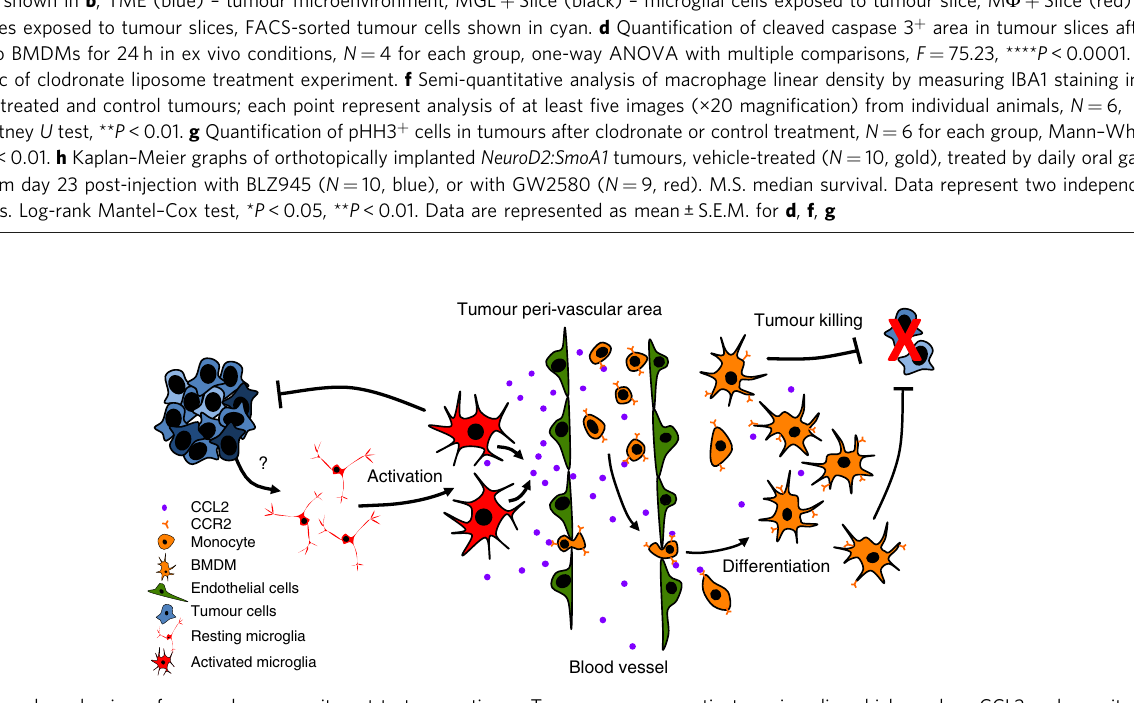
Fig. 5 Cultured macrophages and microglial cells lead to tumour cell death ex vivo. a Schematic of experiment: bone marrow cells were extracted from control B6 mice and allowed to differentiate in culture for 6 days prior to exposure to organotypic medulloblastoma tumour slices. Loosely adherent microglial cells were isolated from brain cell culture mixture after culturing for 10 days in vitro. b qPCR analysis of pro- and anti-in fl ammatory macrophage- associated genes from FACS-sorted GFP + tumour cells and GFP − cells of TME compared to microglial cells (MGL) or macrophages (M Φ ) exposed to tumour slices for 24 h. Two representative samples of 3 – 4 independent experiments for each group are shown. c 2D principal component analysis of PCR gene panel shown in b , TME (blue) – tumour microenvironment, MGL + Slice (black) – microglial cells exposed to tumour slice, M Φ + Slice (red) – macrophages exposed to tumour slices, FACS-sorted tumour cells shown in cyan. d Quanti fi cation of cleaved caspase 3 + area in tumour slices after exposure to BMDMs for 24 h in ex vivo conditions, N = 4 for each group, one-way ANOVA with multiple comparisons, F = 75.23, **** P < 0.0001. e Schematic of clodronate liposome treatment experiment. f Semi-quantitative analysis of macrophage linear density by measuring IBA1 staining in clodronate-treated and control tumours; each point represent analysis of at least fi ve images (×20 magni fi cation) from individual animals, N = 6,